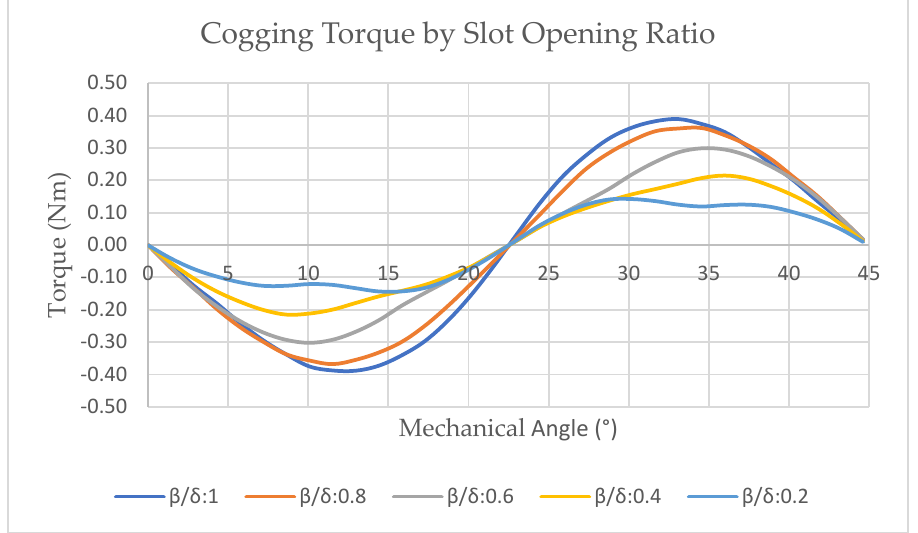
Figure 13. Cogging torque by β/δ ratio.